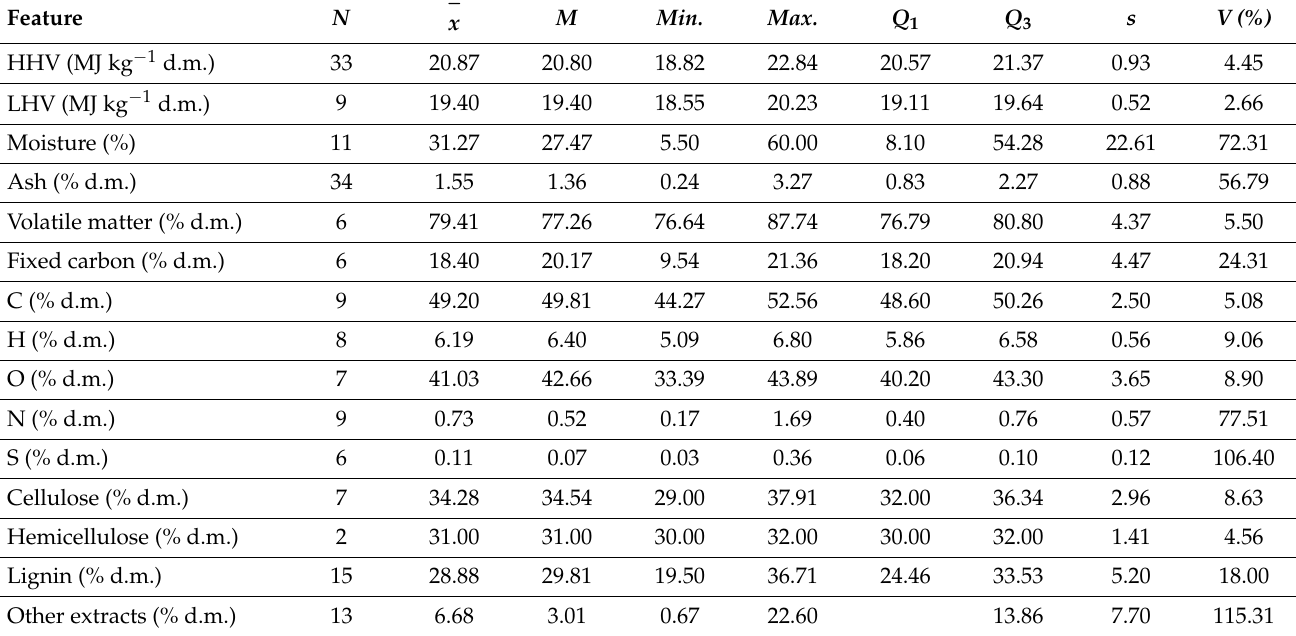
Table 5. Differentiation of thermophysical properties and elemental composition of coniferous branches.